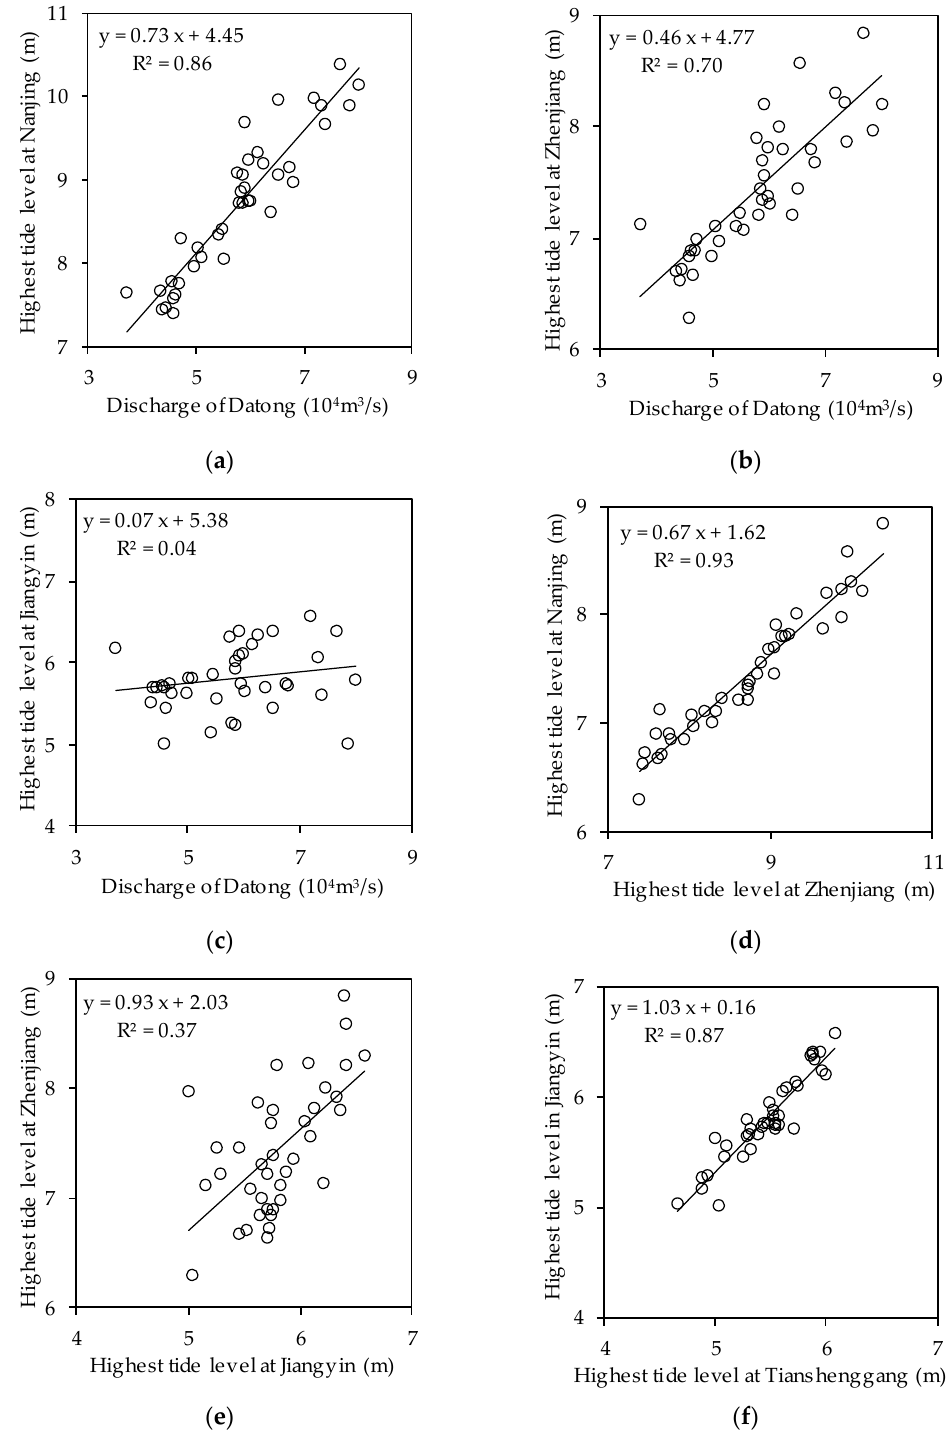
Figure 5. Relationship between the highest tide level, income flow discharge, and the downstream highest tide level: ( a ) highest tide level at Nanjing and discharge of Datong; ( b ) highest tide level at Zhenjiang and discharge of Datong; ( c ) highest tide level at Jiangyin and discharge of Datong; ( d ) highest tide level at Nanjing and Zhenjiang; ( e ) highest tide level at Zhenjiang and Jiangyin; ( f ) highest tide level at Jiangyin and Tianshenggang.